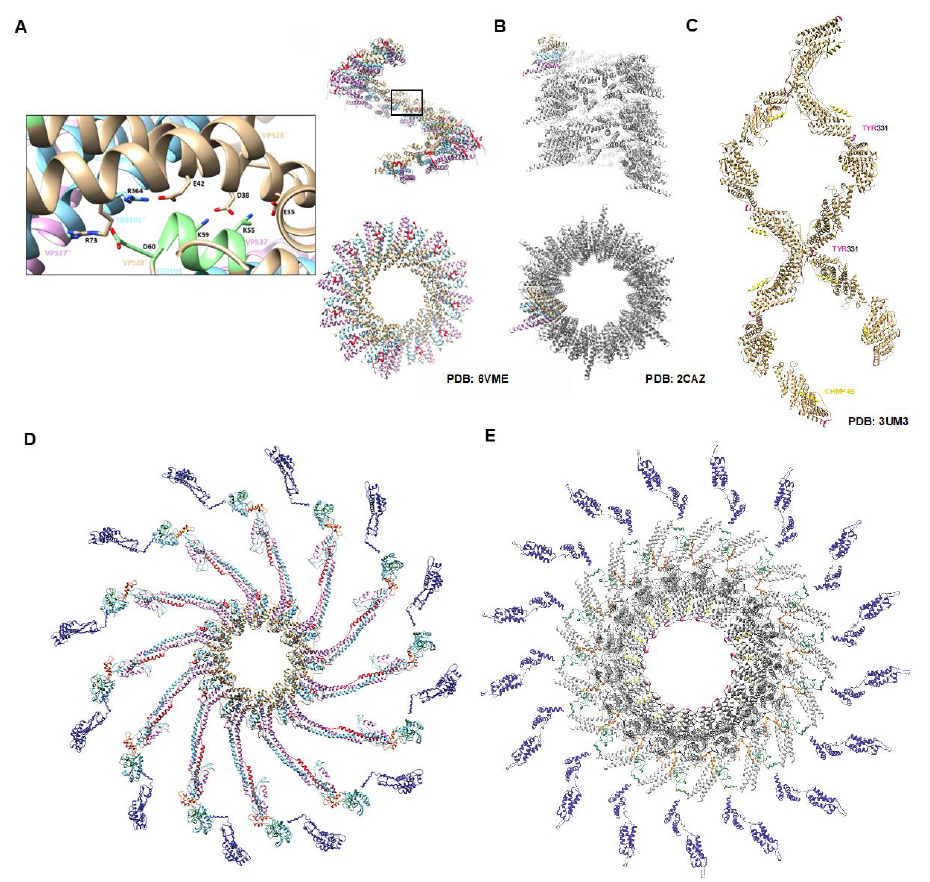
Figure 1. ESCRT-I and ALIX helical assemblies are required for retroviral budding. Crystal structures of human ESCRT-I revealed that the hetero-tetramer core forms filaments mediated principally by contacts within VPS28. ( A ) Filament of human ESCRT-I as determined by X-ray crystallography. VPS28 is colored in beige, TSG101 in blue, VPS37 in pink, and MVB12 in red. Two views of the filament are shown for comparison of the helical and luminal parameters. Inset reveals VPS28 residues essential for filament formation colored in green. ( B ) Filament of the yeast ESCRT-I derived from a crystal (Teo et al., [21]). The individual yeast components are colored the same way as in ( A ) with the exception of MVB12 due to its absence in yeast. Note that the yeast filament adopts a one-start helix and a larger luminal width than that of human ESCRT-I which is a tighter three-start helix. ( C ) Lemniscate helix of Bro-1-domain protein Brox in the presence of a CHMP4B peptide (yellow). Brox is shown in beige with the FIY motif colored in pink at each interface (Mu et al., [35]). ( D ) Molecular modeling derived from the study by Rose et al. (submitted for review) of the yeast-derived human ESCRT-I complex bound to Gag. ESCRT-I components are colored in the same fashion as above and Gag is shown with CA in blue, NC in green, and p6 in orange. The VPS28 multimerization domain is highlighted in light green. ( E ) Luminal view of the molecular model for an ideal full-length ALIX helical assembly bound to Gag. ALIX is shown in grey with its Bro1 multimerization domain in pink. The CHMP4B peptide can be seen between ALIX dimers in gold. Due to di ff erences in length between ALIX and ESCRT-I, the ALIX oligomer adopts a wider luminal width and larger helical repeat (18 copies of ALIX per turn versus 12 for ESCRT-I) in order to accommodate the diameter of assembling retroviral